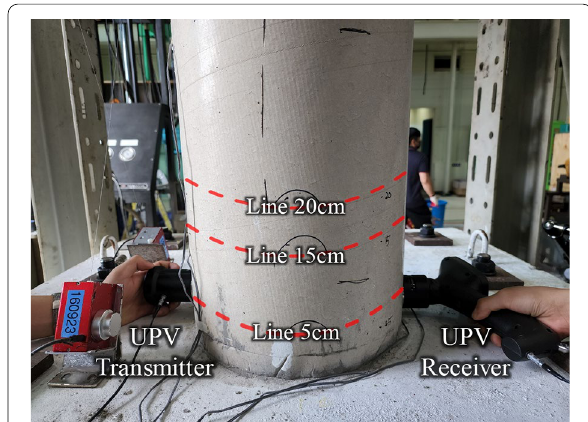
Fig. 8 Example of UPV measurements and locations